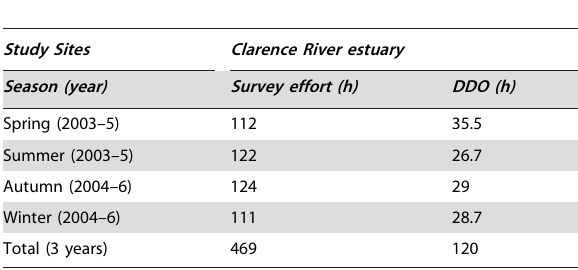
Table 1. Boat-survey effort and direct dolphin observation (DDO) periods during each